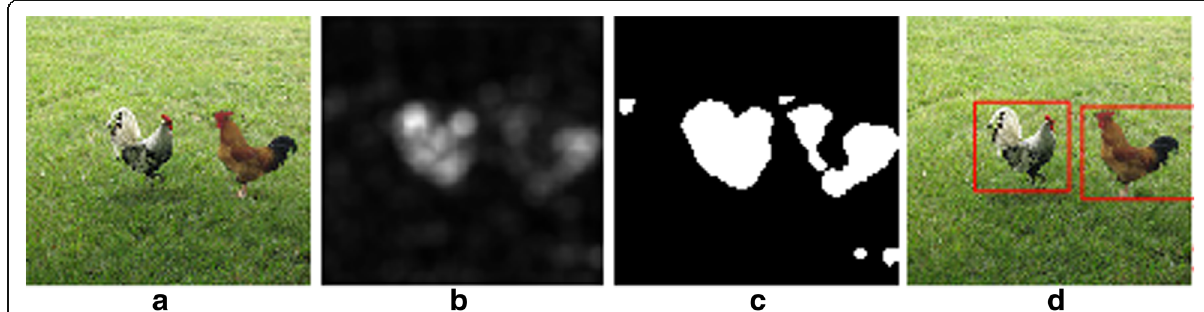
Fig. 3 Saliency detection using spectral residual: a an original image, b the saliency map, c salient regions after thresholding, and d two largest connected salient regions are marked with red circumscribed rectangles